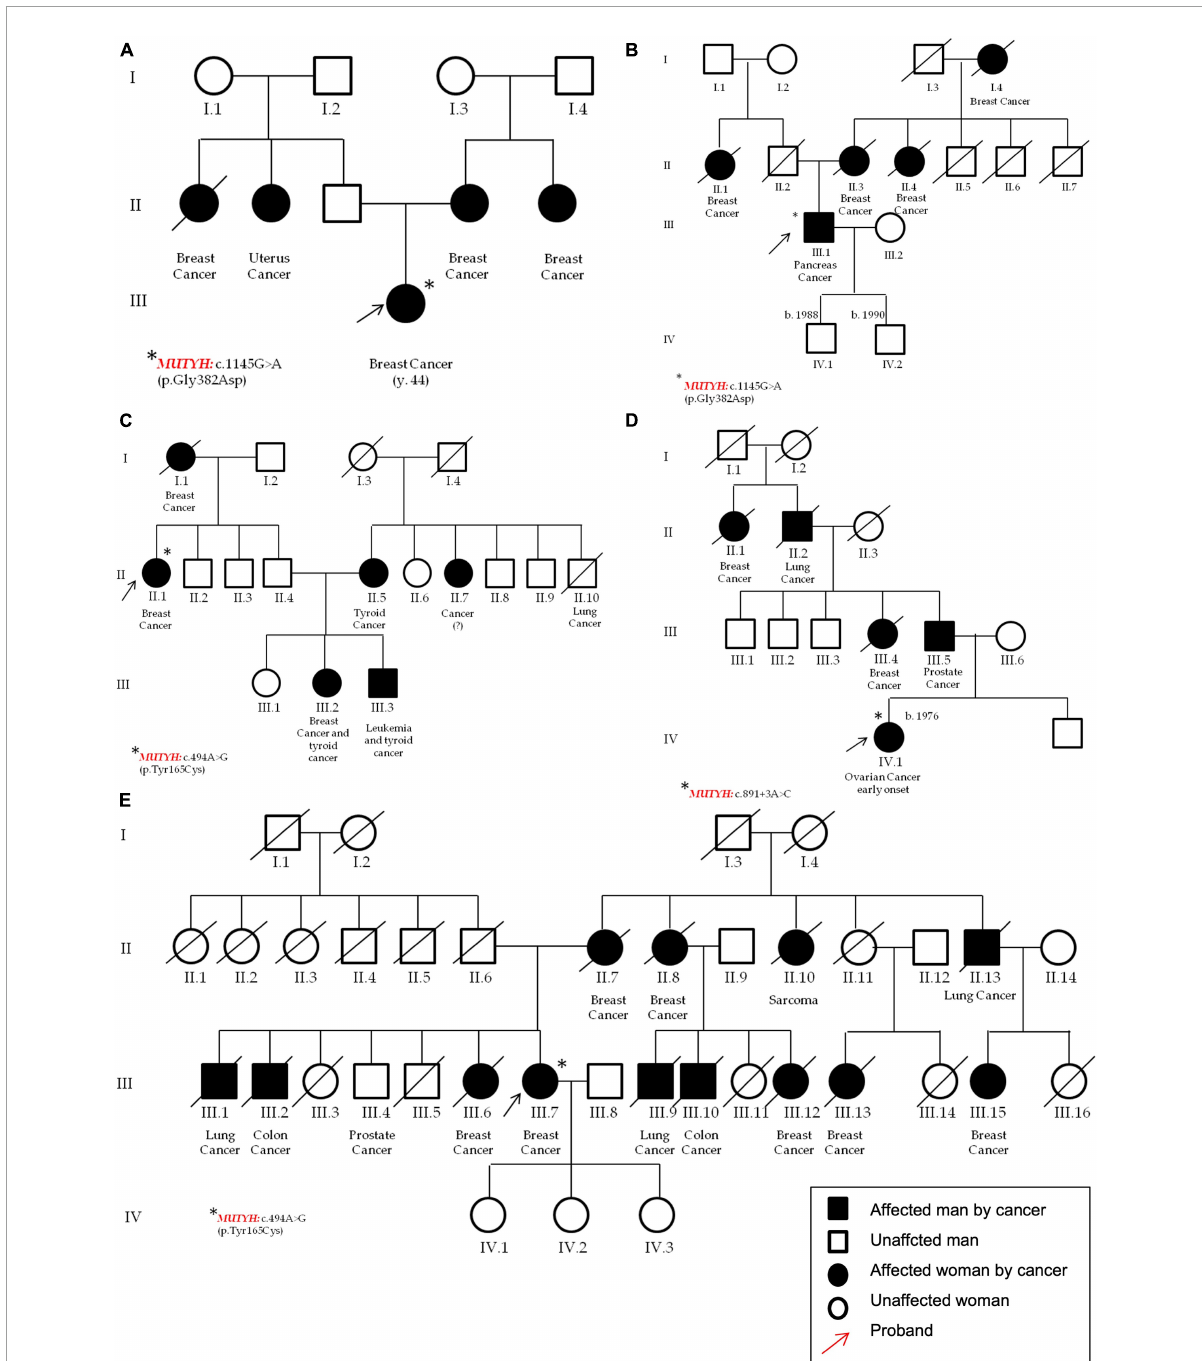
FIGURE6 Pedigrees of the patients that carry pathogenic variants in the MUTYH gene. In detail, in (A) (P21) and (B) (P39) one female and one male that carry the c.1103G > A p.(Gly368Asp); in (C) (P24) a patient with c.452A > G, p.(Tyr151Cys); and in (D) (P52) a female with the c.891 + 3A > C. Pedigree (E) (P15) of the second patient carrying the MUTYH variant c.452A > G, p.(Tyr151Cys). All the probands are highlighted by red arrows and the asterisks identifies MUTYH different variants.